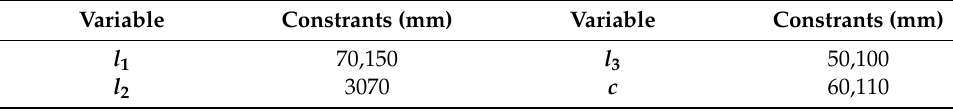
Table 4. Variable constraints.